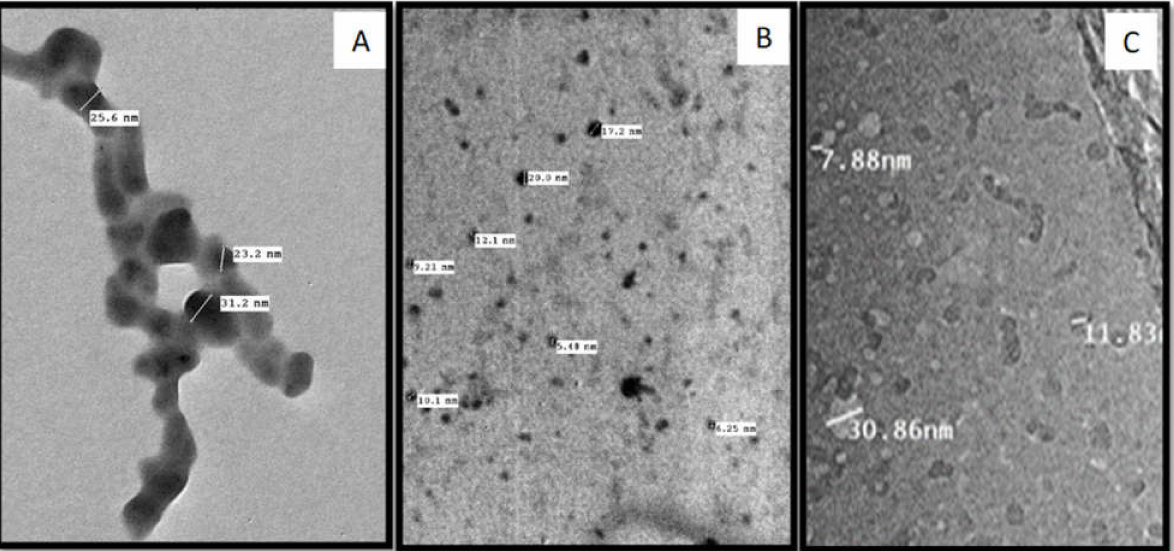
Figure 4. Transmission electron microscopy (TEM) image of prepared ( A ) GAS-NPs, ( B ) SA-NPs, and ( C )